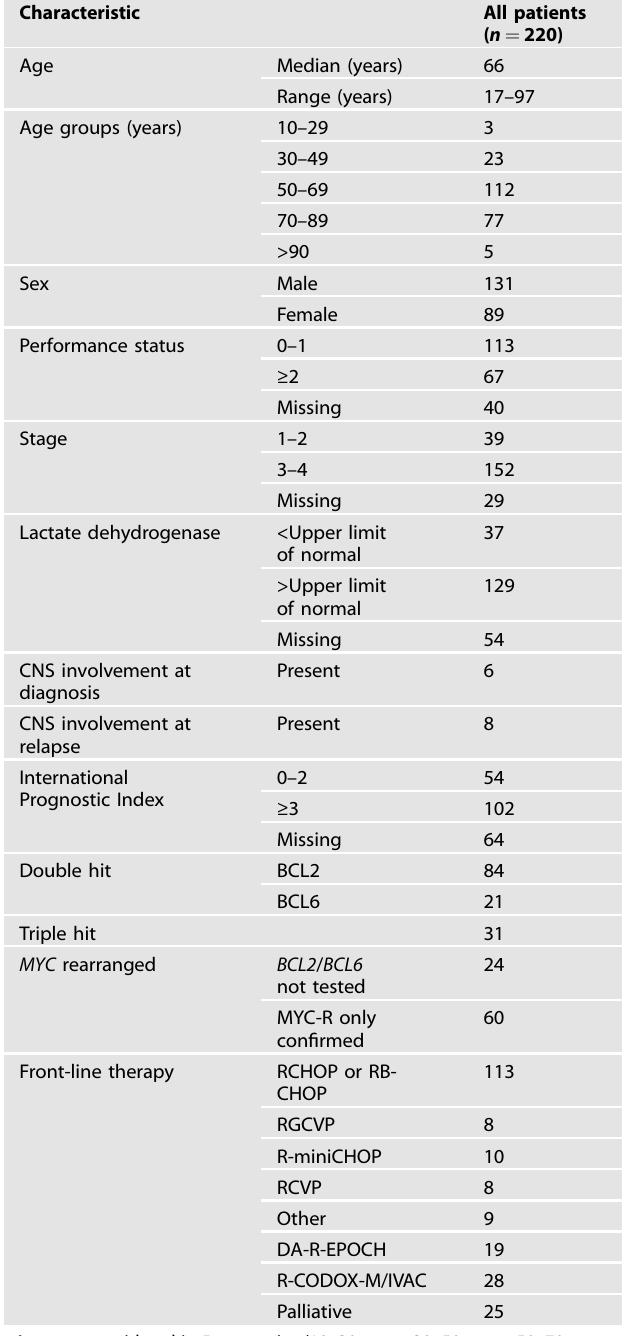
Table 1. Patient characteristics.